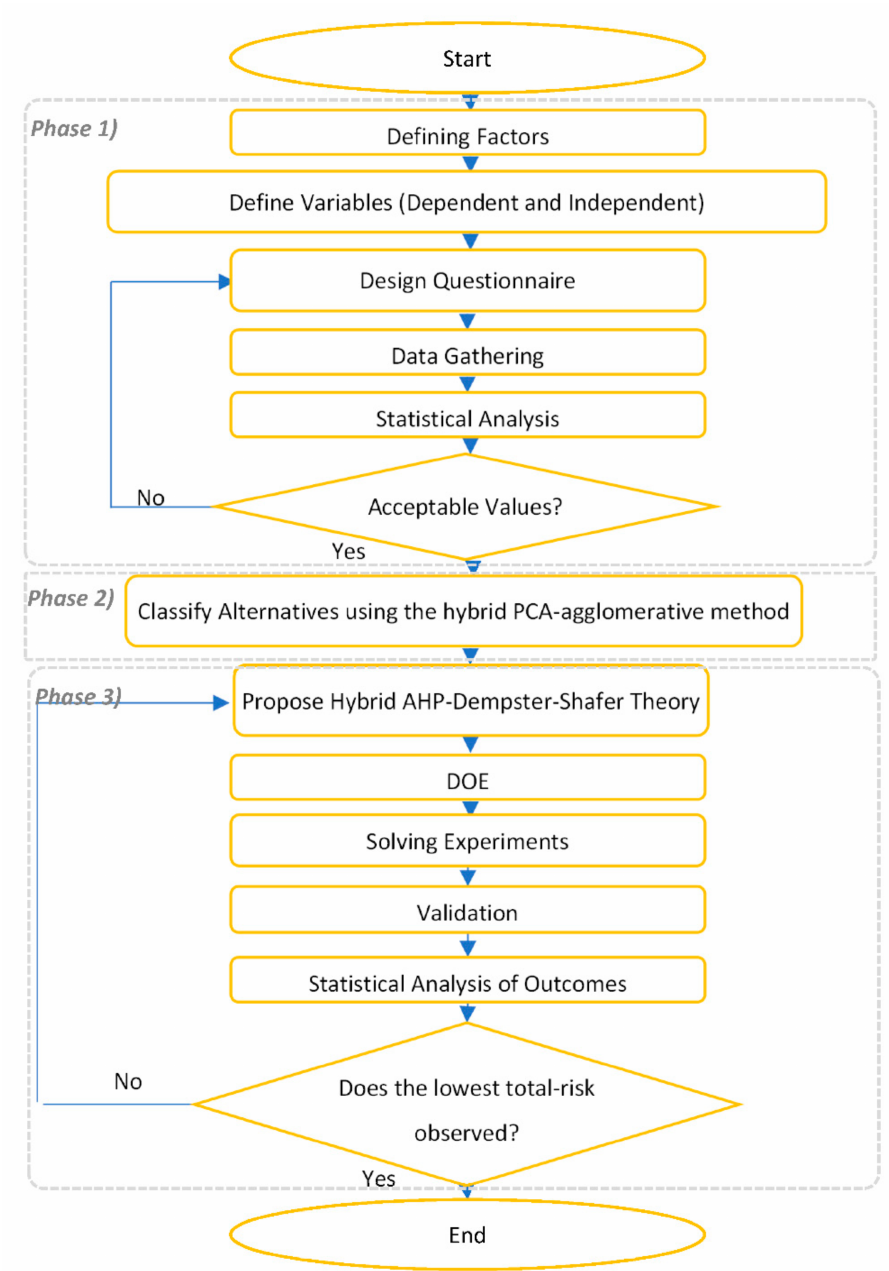
Figure 2. Flowchart of the research